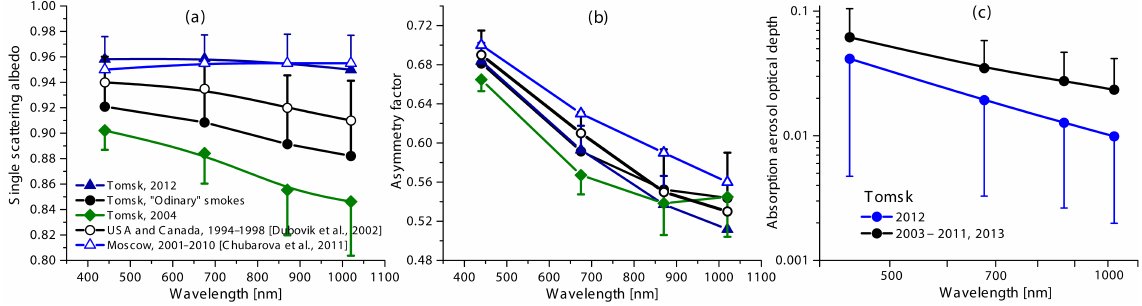
Figure 12. Average (a) SSA and (b) AF for different periods and regions of observations and (c) average spectral absorption aerosol optical depth for 2012 extreme and ordinary smoke; the error bars indicate the standard deviations. One-sided error bars are used in order not to overburden the